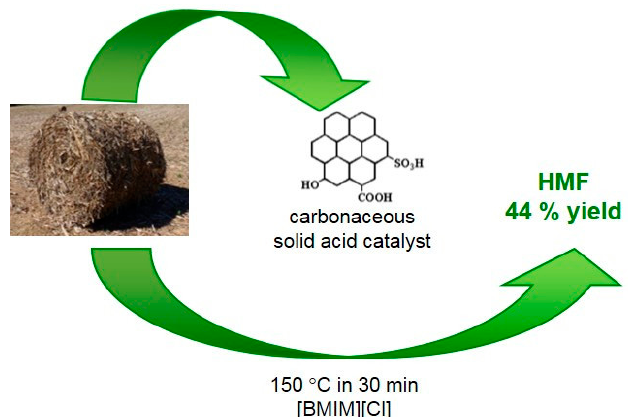
Figure 8. Schemes of the process from corn stalks to be used both for the synthesis of the catalyst and as raw biomass to be transformed into HMF [43]. as raw biomass to be transformed into HMF